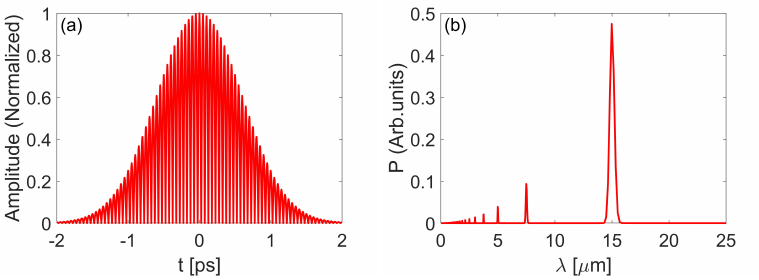
Figure 3. The longitudinal amplitude distribution ( a ) and beating frequency ( b ) of the seed laser.